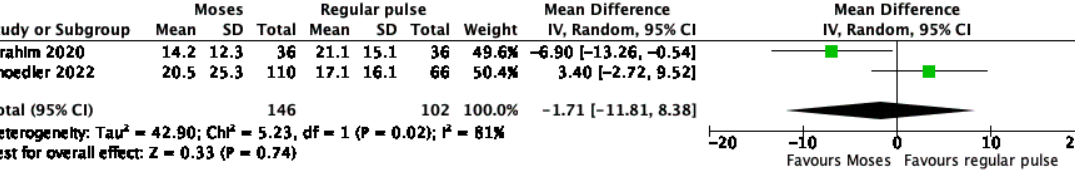
Figure 4. Forest plot of the meta-analysis comparing fragmentation time between Moses versus regular pulse modulation [18,35].